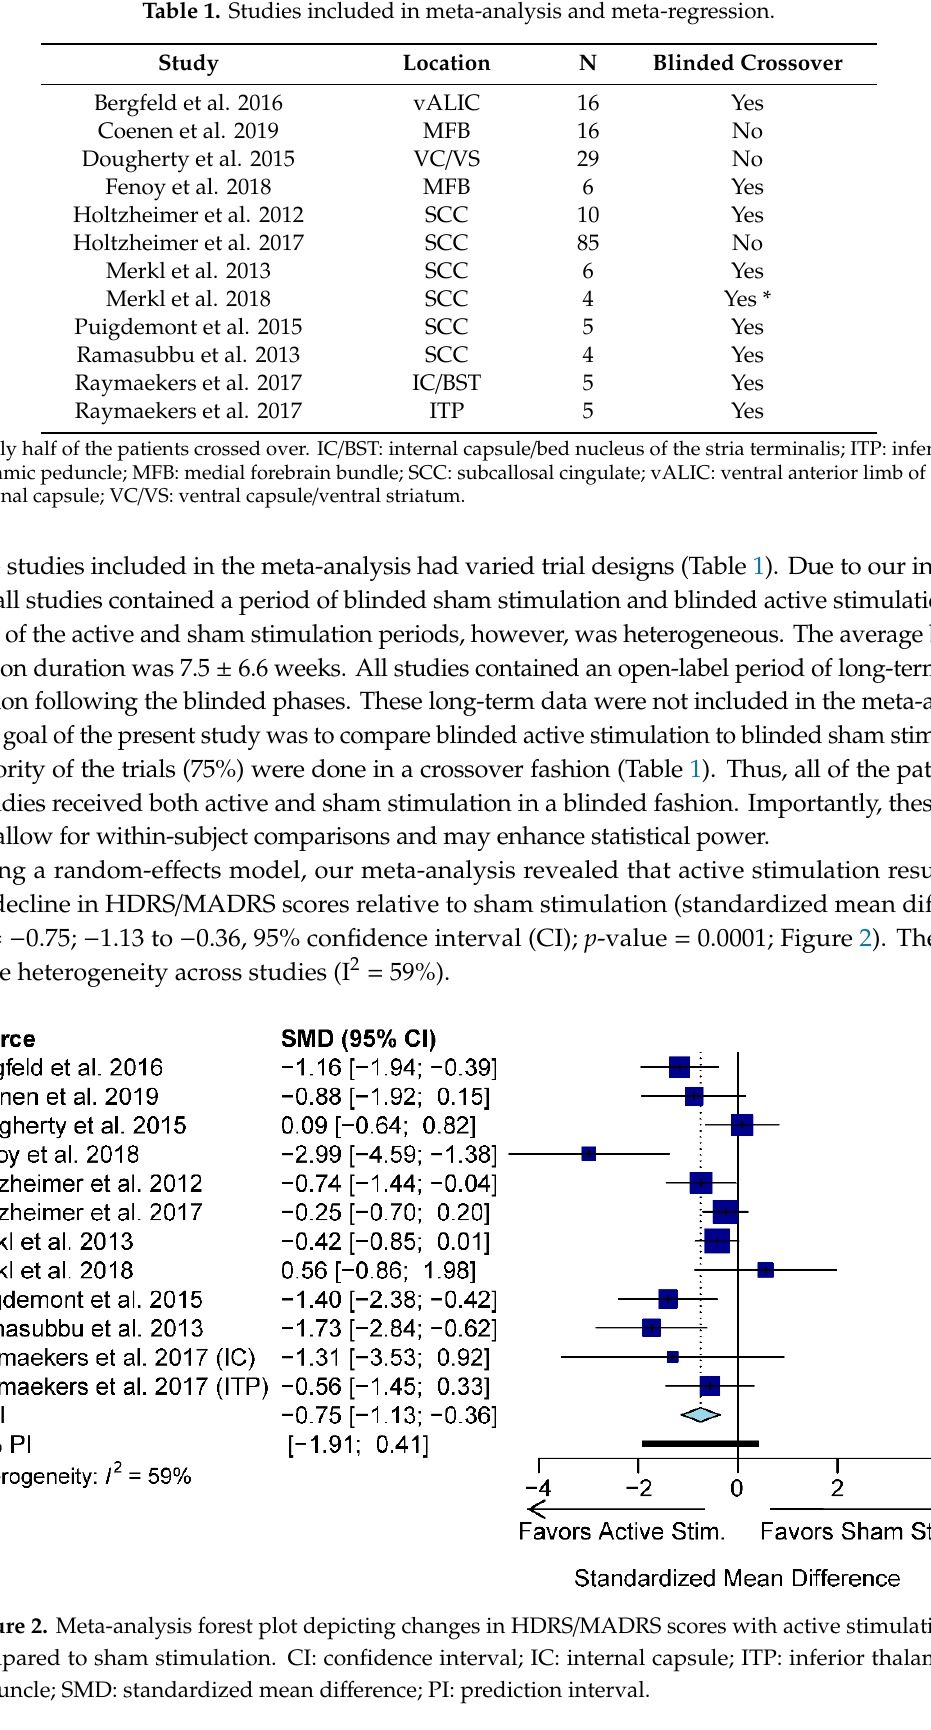
Table 1. Studies included in meta-analysis and meta-regression.